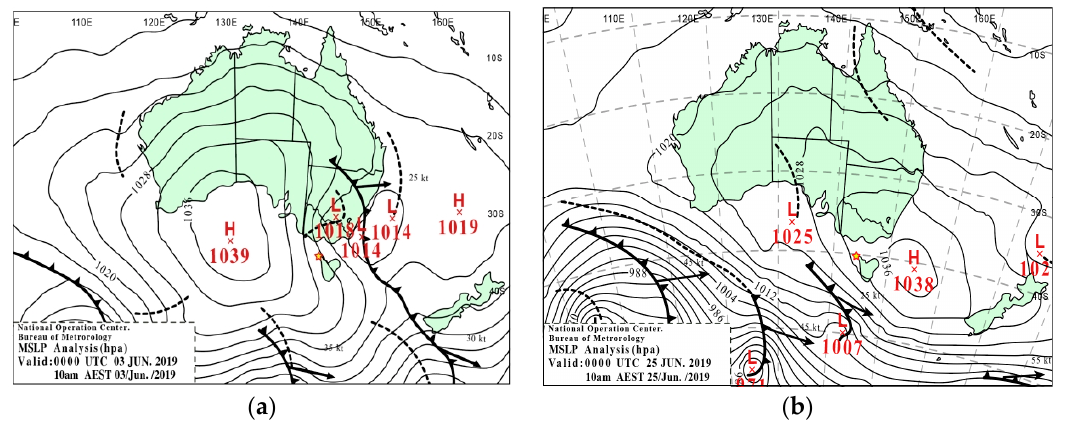
Figure 3. Mean sea-level pressure (MSLP) analyses show a high-pressure system west of observing site (yellow star) on ( a ) 3 June 2019 and on ( b ) 25 June 2019. Data are from the Australia Bureau of Meteorology (http://www.bom.gov.au/australia/charts/archive/index.shtml, accessed on 8 May, 2022).